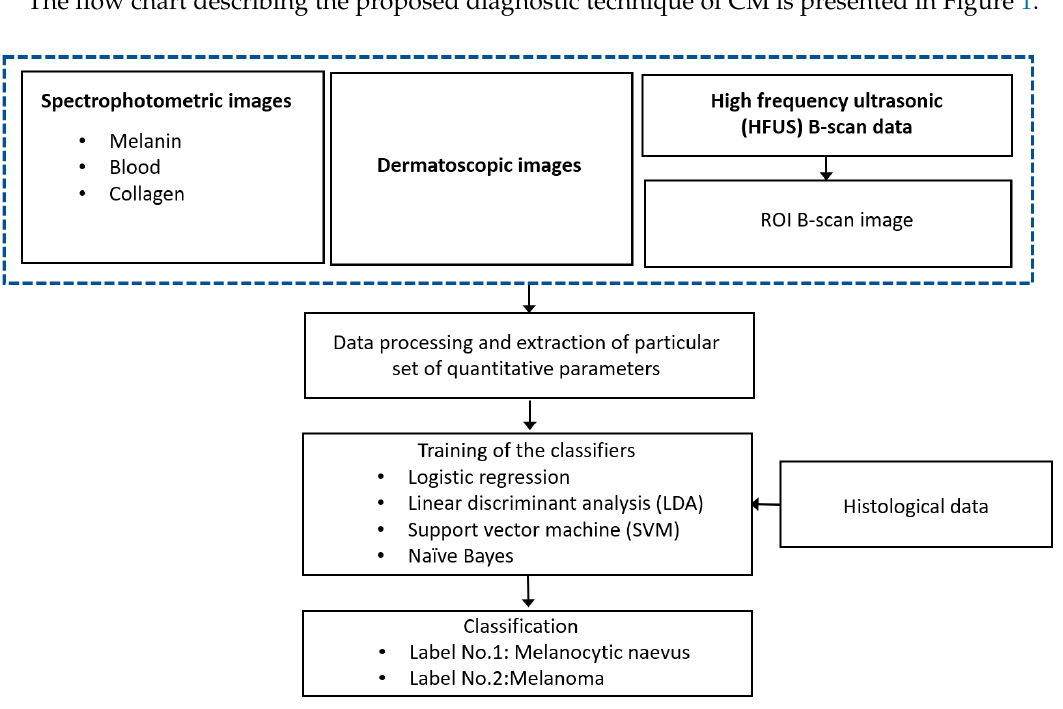
Figure 1. Flow chart description of the proposed diagnostic technique.